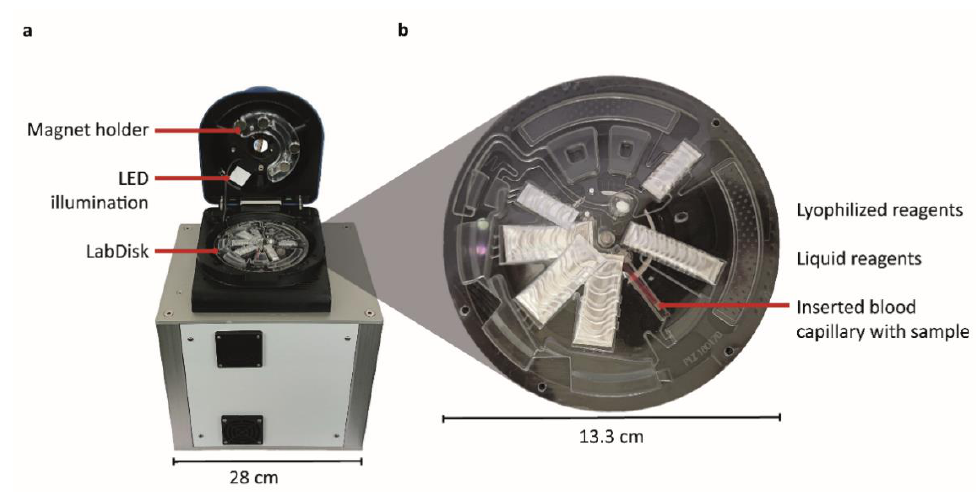
Figure 1. Photographs of ( a ) the standalone point-of-care testing (POCT) instrument with centrifuge, incubator and fluorescence camera and ( b ) the microthermoformed microfluidic LabDisk cartridge. A detailed overview of the LabDisk cartridge and its pre-stored reagents is depicted in Figure 2.